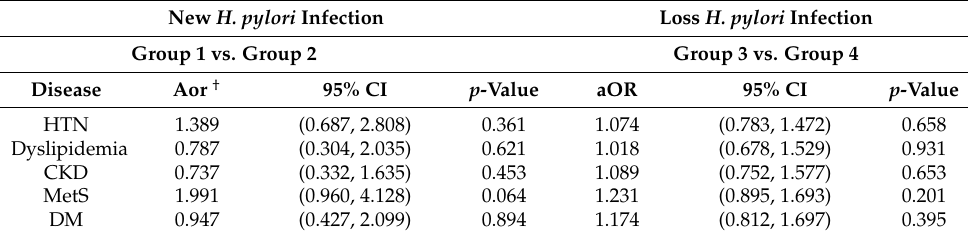
Table 4. Impact of H. pylori infection status change on diseases development. New H. pylori Infection Loss H. pylori Infection Group 1 vs. Group 2 Group 3 vs. Group